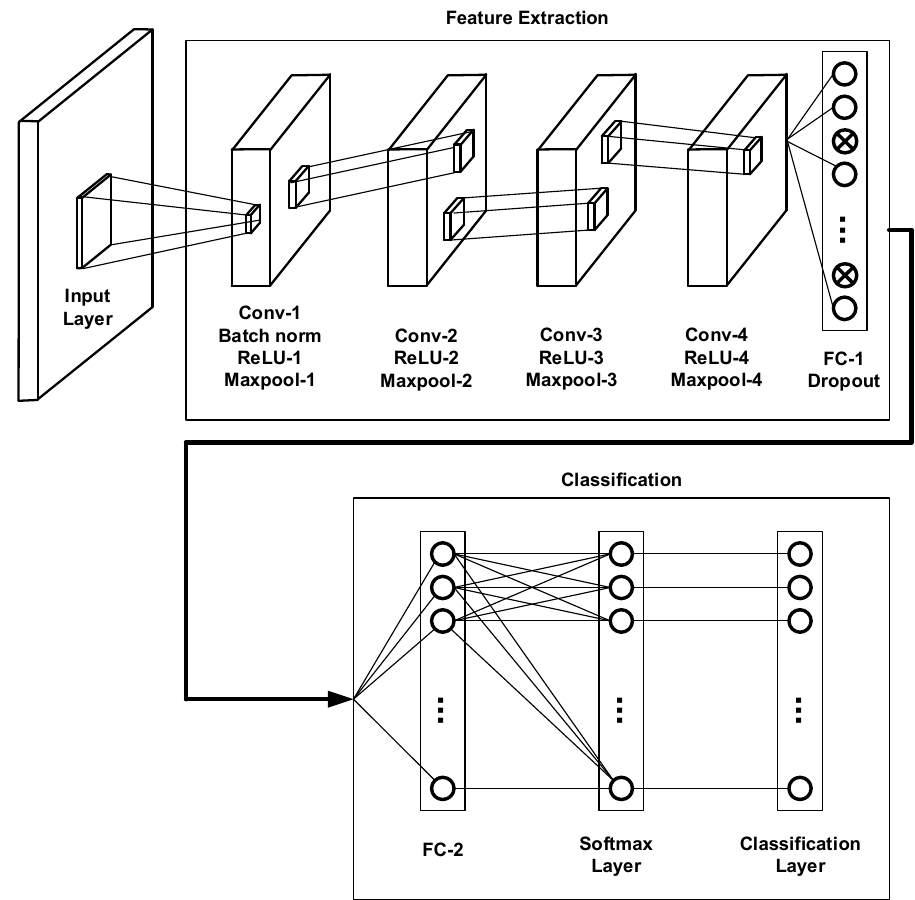
Figure 10. Proposed CNN model